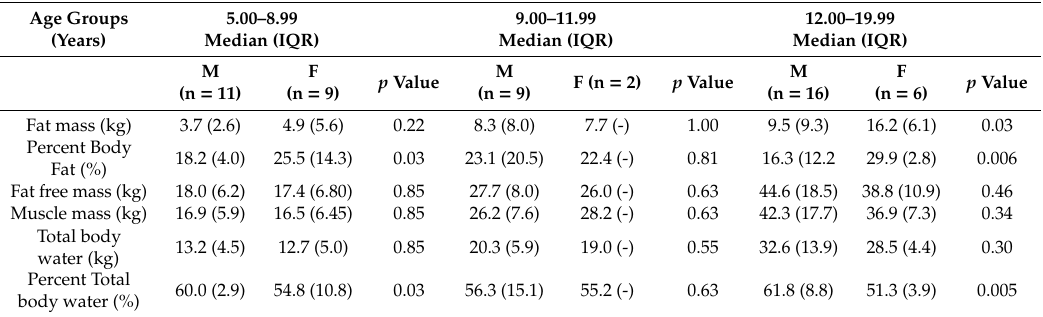
Table 3. Medians and interquartile ranges (IQR) of body composition in participants aged 5–19.99 years. Age Groups